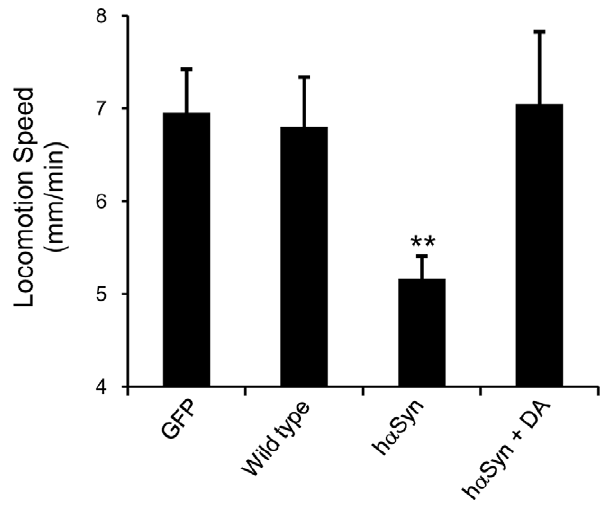
Figure 2. h a Syn expression leads to a motor deficit. Locomotion speed was quantified in day 2 adult worms. **: p , 0.01 (one way ANOVA with Dunnet’s post-hoc test). n varies 10 to 15. Error bars indicate SEM. This deficit was not observed after addition of 1 mM